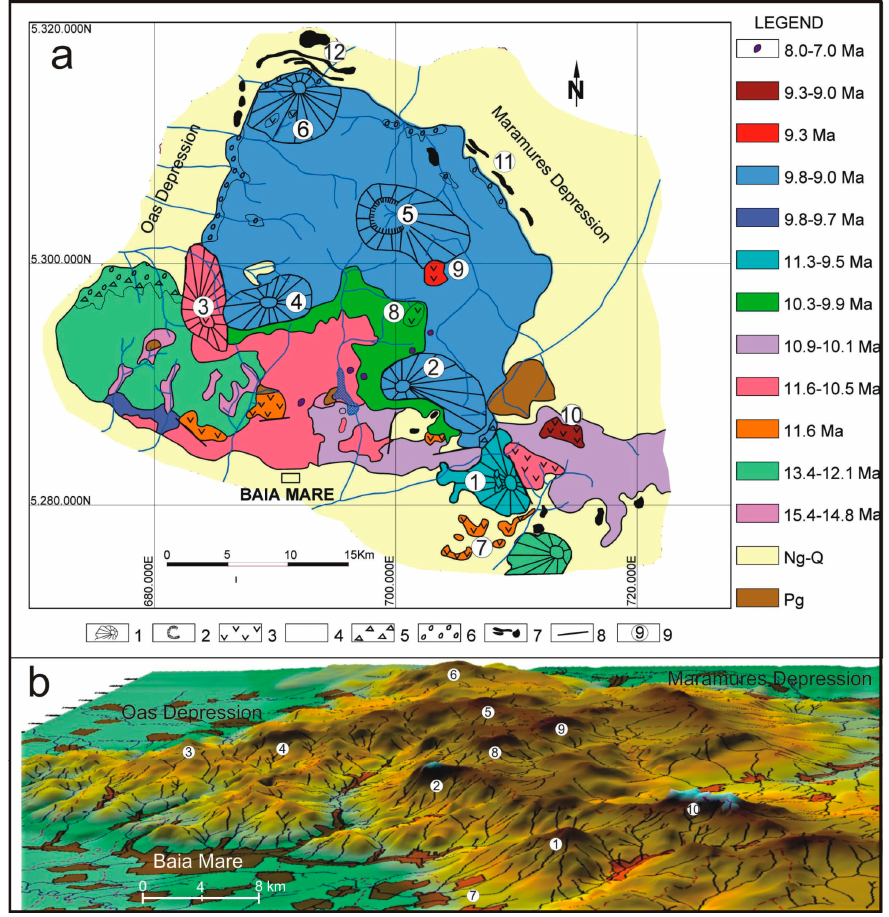
Figure 4. Volcanological sketch map (updated after Kovacs et al. [25], ( a ) and digital terrain map ( b ) of the Gutâi Mountains Legend: 1. Composite volcanoes; 2. Crater; 3. Extrusive domes; 4. Lava flows (prevalent) and volcaniclastics; 5. Volcaniclastic rocks (hyaloclastites, pyroclastic rocks); 6. Reworked volcaniclastics (epiclastic rocks); 7. Intrusions; 8. Faults; 9. The volcanic structures listed in the text: Composite volcanoes: 1. Mogo ş a; 2. Igni ş ; 3. Muntele Mic; 4. Pietroasa; 5. Rotundu; 6. Muntele Bradului; Extrusive domes: 7. D ă ne ş ti-Cet ăţ ele; 8. Breze; 9. Ple ş ca Mare; 10. Gutâi; Intrusive bodies: 11. Agri ş sills; 12. Cherec sills. The color legend represents the volcanic rocks (as temporal evolution/geochronological ages) and the sedimentary deposits (Pg—Paleogene; Ng–Q—Neogene– Quaternary) of the Gutâi Mountains.